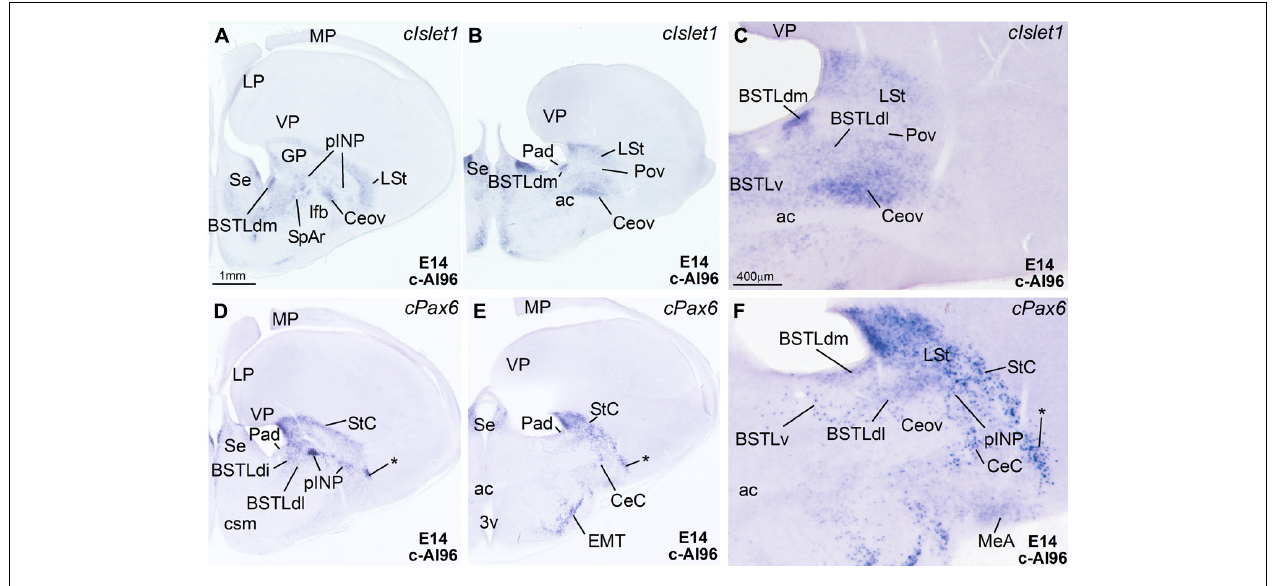
respectively.The asterisk in (D–F) is pointing to cPax6 -expressing cell patches, intercalated between CeC and the arcopallial amygdala, which are continuous dorsally with those in the StC and medially with those in pINP. See text for more details. For abbreviations, see list. Scale bars: A = 1 mm (applies to A,B,D,E ); C = 400 μ m (applies to C,F